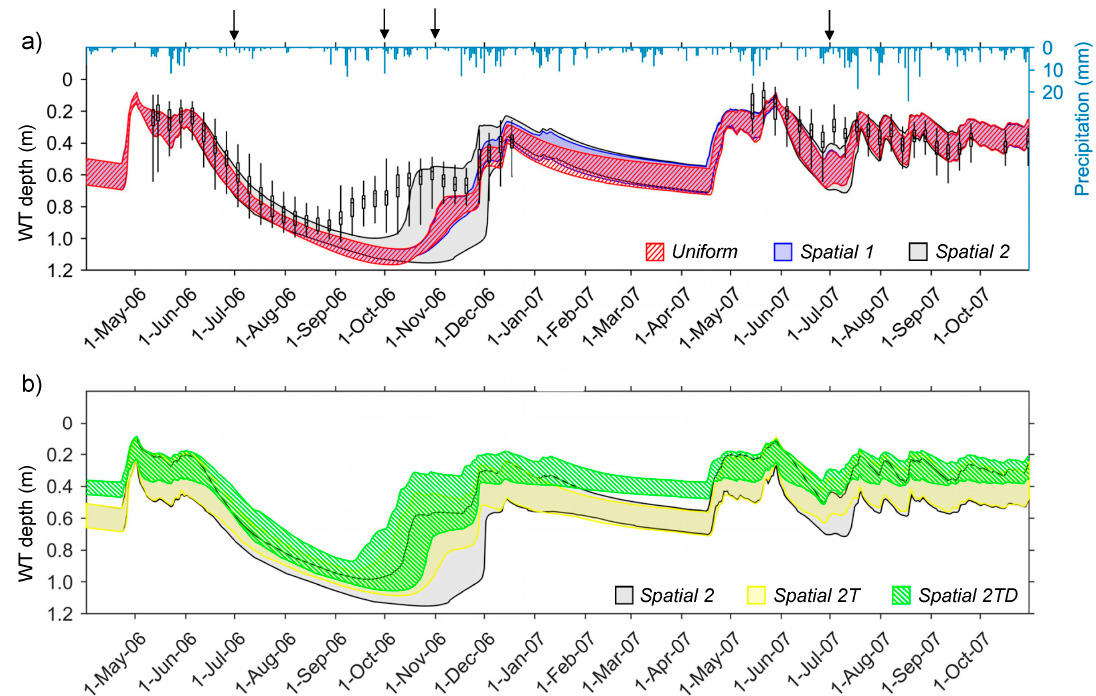
Figure 5. Modeled (shaded areas) and measured (box plots) water table (WT) depth in Sattasuo with prevailing tree stand ( a ) and comparison between Spatial 2 , Spatial 2T , and Spatial 2TD model scenarios ( b ). Shaded areas represent the variation between minimum and maximum modeled WT depths in the groundwater tube locations ( a ) and the 5% and 95% percentile of the modeled values over the modeled area ( b ). The arrows mark the dates for spatial representation of WT depths in Figures 6 and 7.